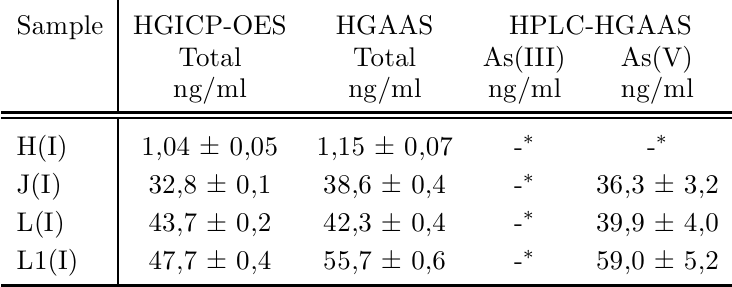
Table 4 Results of determination forms of arsenic